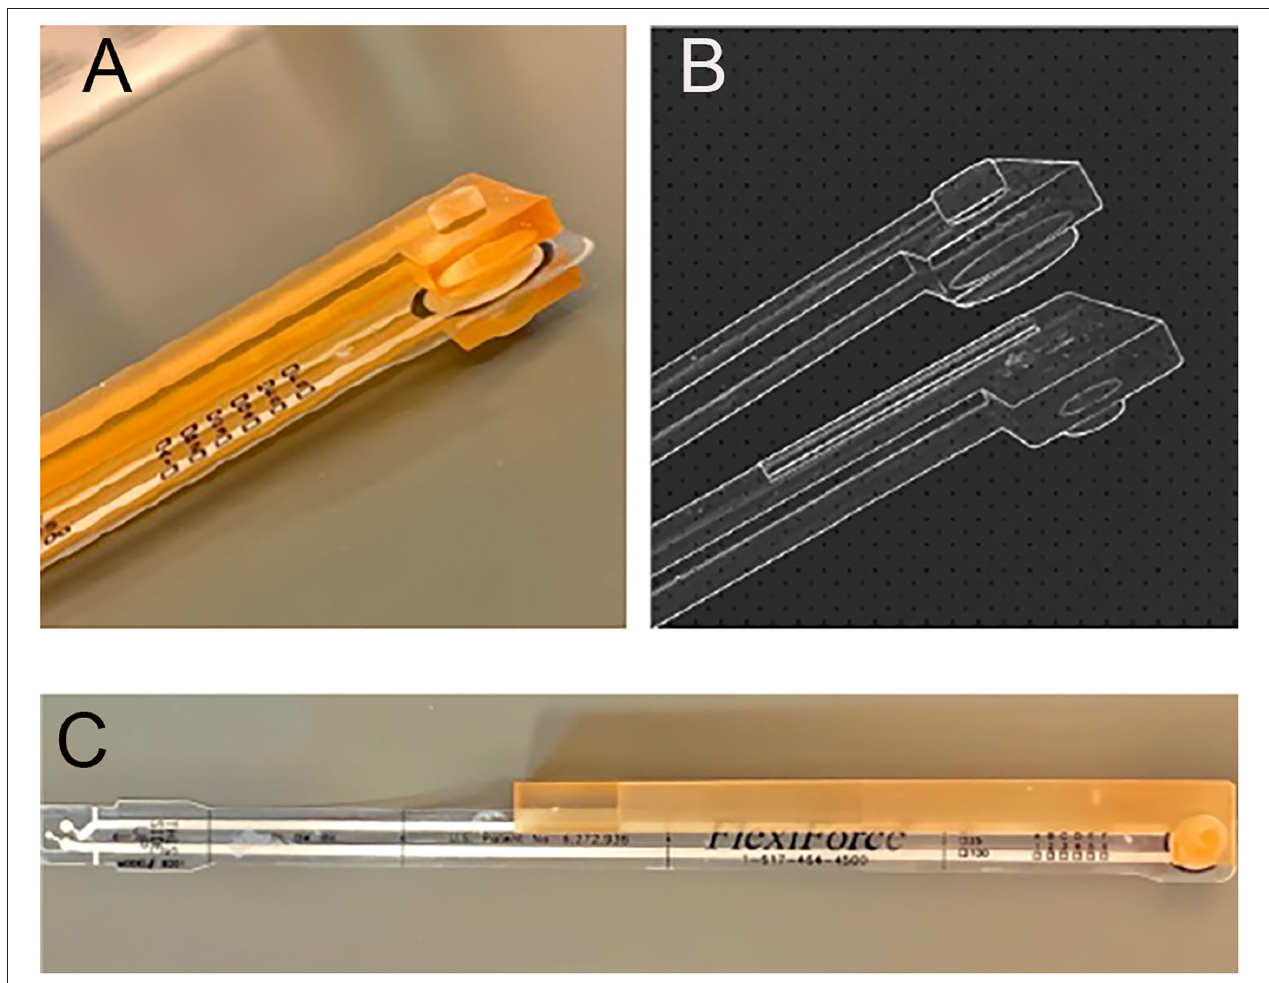
FIGURE 1 | 3D-printed intraoral apparatus covering a FlexiForce (Tekscan Inc., MA, USA) pressure sensor designed and developed to measure bite force value. (A) Photograph of biting area showing protuberance to focus force on one tooth. (B) Detail from planning file. (C) Overview showing the encapsulation of the FlexiForce